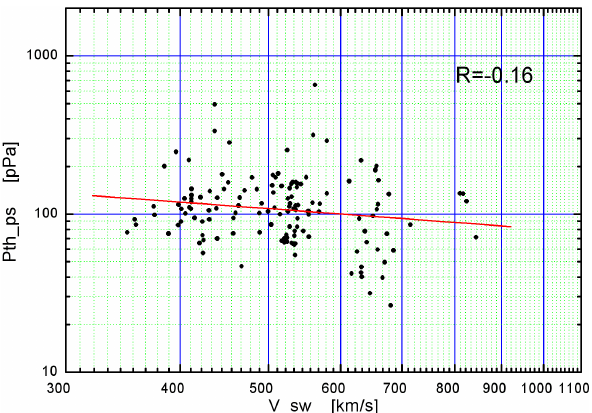
Fig. 9. The relationship between the speed of the solar wind and the ion thermal pressure in the plasma sheet while IMF B z > −